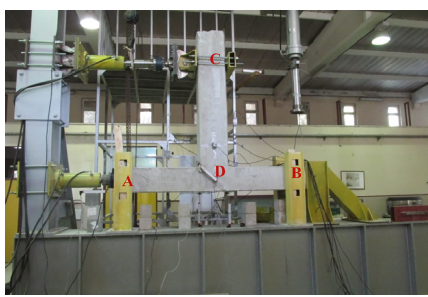
Figure 8: Loading system and a